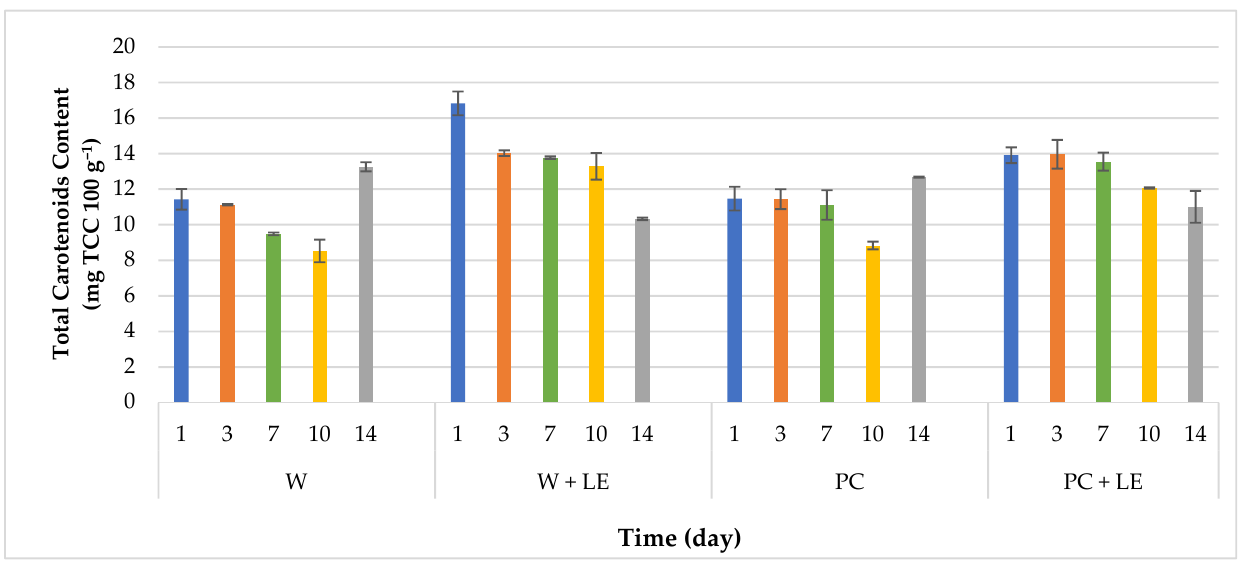
Figure 6. Total carotenoids content of uncoated and coated fresh-cut carrots throughout 14 days of storage (4°C).Abbreviations: W; W + LE; PC; PC + LE (see Table 1).